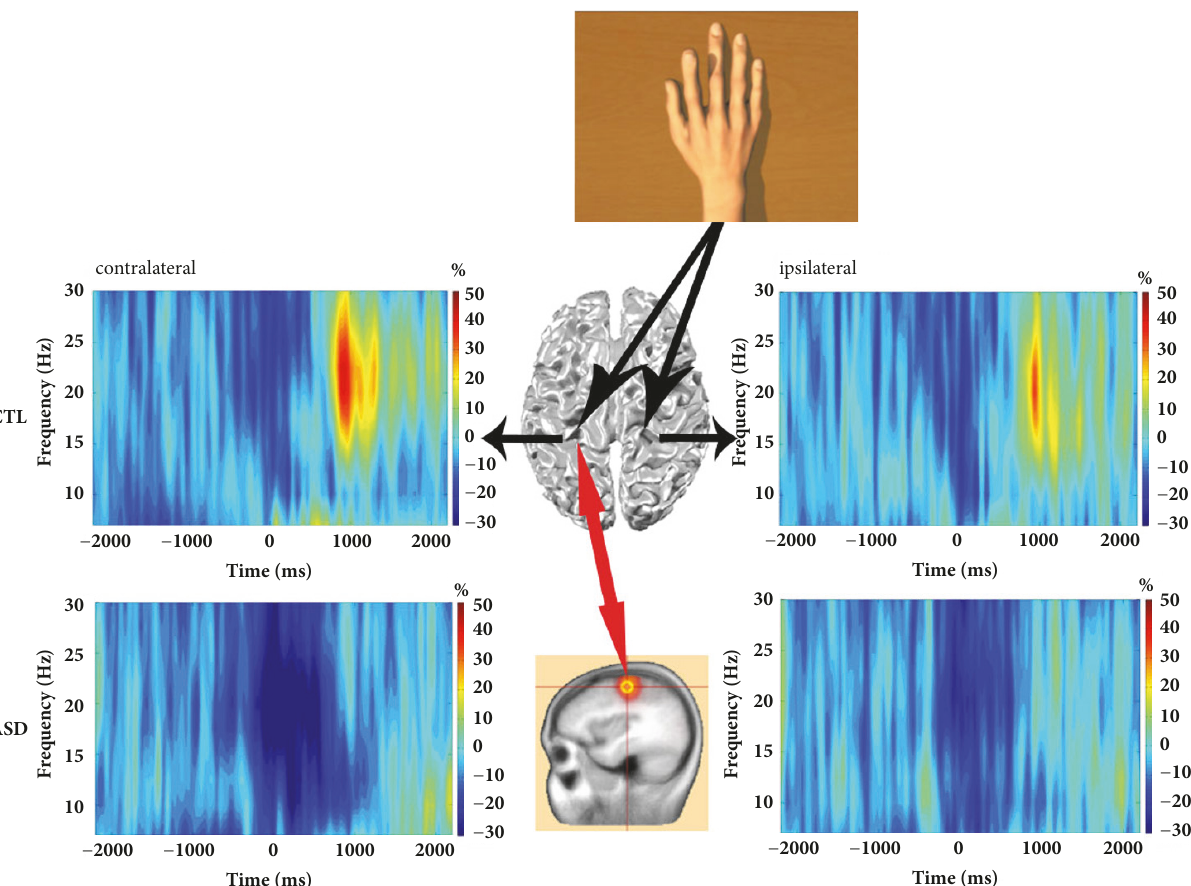
Figure 2: Grand average of time-frequency spectra of CTL (control, top) and ASD (bottom) children. TFR plots are derived from beamforming source images localized in the contralateral and ipsilateral motor areas and time-locked to movement termination (accelerometer onset). Cortical oscillations in the mu- (8-13Hz) and beta- (15-30Hz) bands showing event-related desynchronization (ERD, blue) at movement onset and postmovement beta rebound (PMBR, yellow-red) time regions are characterized. Source power during the baseline period was subtracted from source power during movement or after the movement intervals. Control subjects had a significant power decrease (ERD) in percent change from baseline in the beta frequency range beginning before movement and lasting throughout the duration of movement as well as a mu-ERD around the movement, which were followed by a strong beta power increase (PMBR) in percent changefrombaselinebeginningshortlyaftermovementtermination.On thecontrary,ASDsubjectshadasignificantlygreaterpowerdecrease (ERD) compared to controls in the beta and mu frequencies range beginning before movement and lasting beyond the movement, which was followed by a weak or no beta power increase (PMBR) beginning shortly after movement